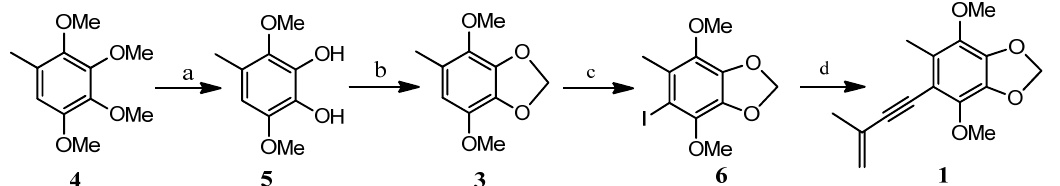
Scheme 1. The synthetic route to compound 1 .